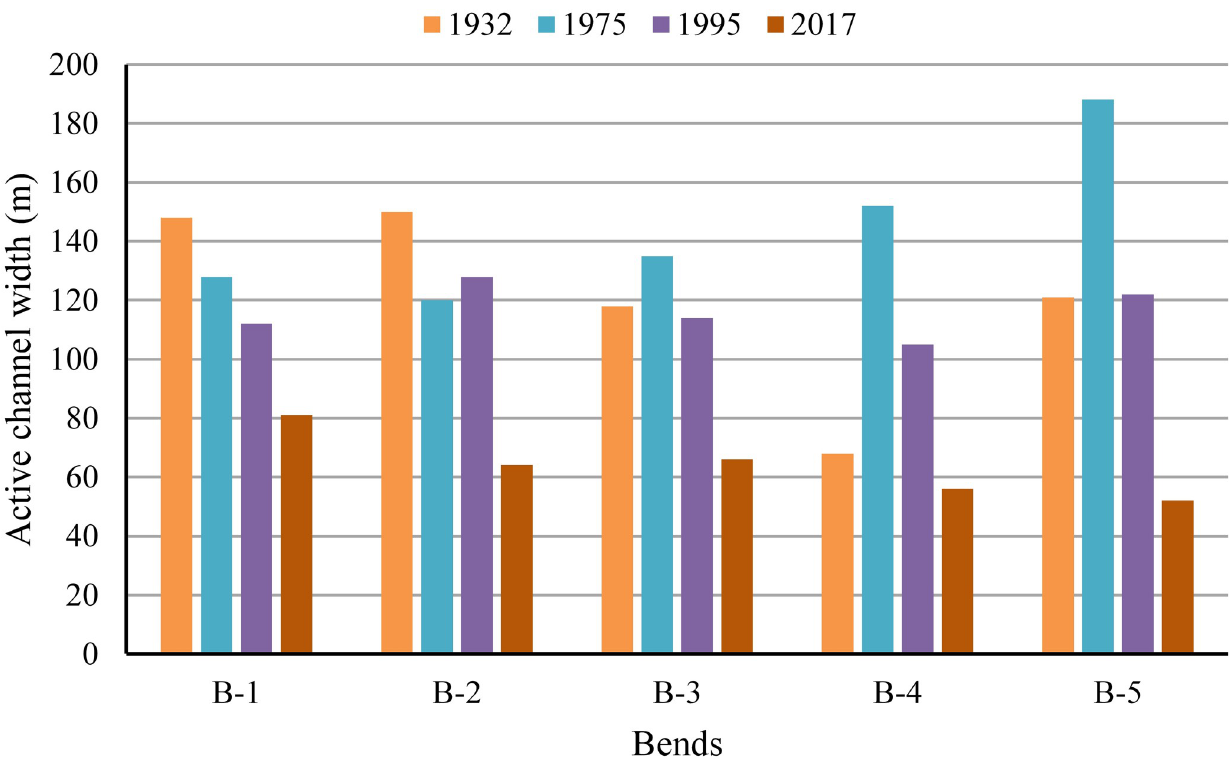
Fig 8. Width of River Manu for various years at the apex of selected five bends.